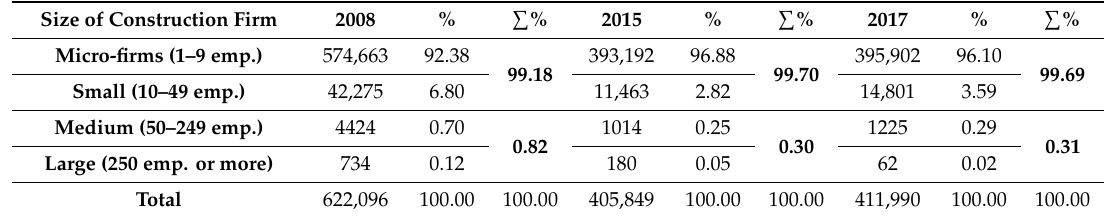
Table 1. Spanish construction firms, classified by size, in accordance with the number of workers regulated in Recommendation 361 / 2003 of the European Commission over the period between